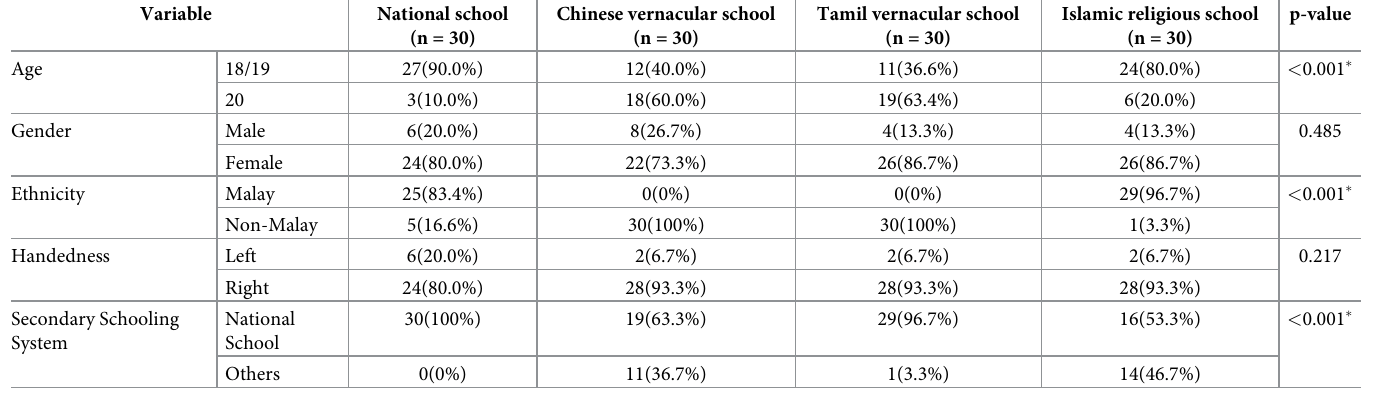
Table 1. Description on demographic information of the participants (N =